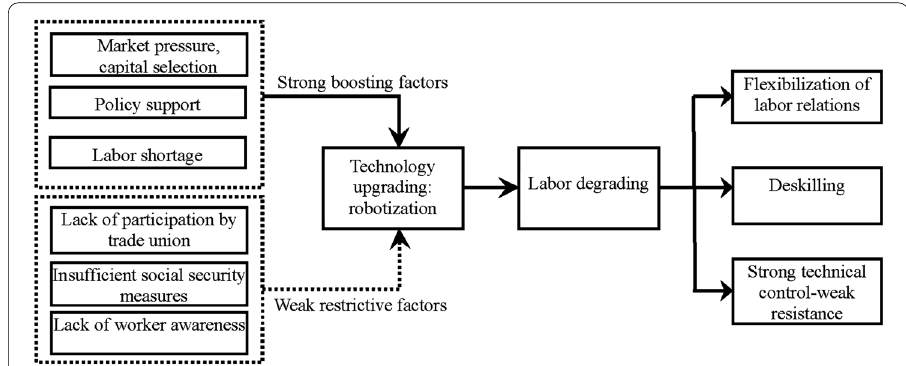
Fig. 1 The formation mechanism of